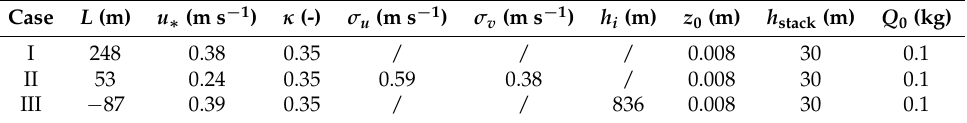
Table 1. Parameter values used in the convergence study to evaluate the parameterizations in